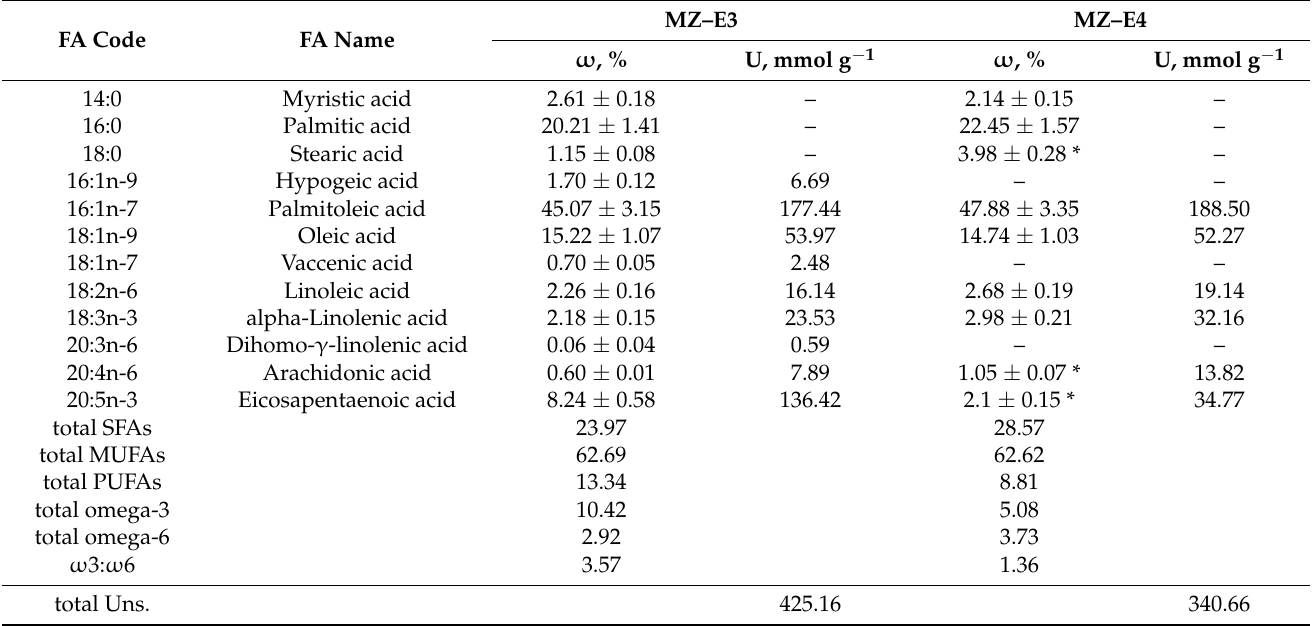
Table 1. Fatty acid profile of Vischeria vischeri